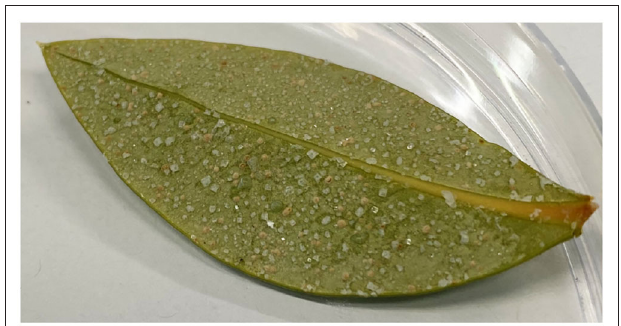
FIGURE 1 | Naturally occurring salts on the freshly cut abaxial leaf surface of “Cabinet mangrove” (gray/white mangrove Avicennia marina ). The salts are present on the leaf due to glands that excrete salt and the leaf is visibly